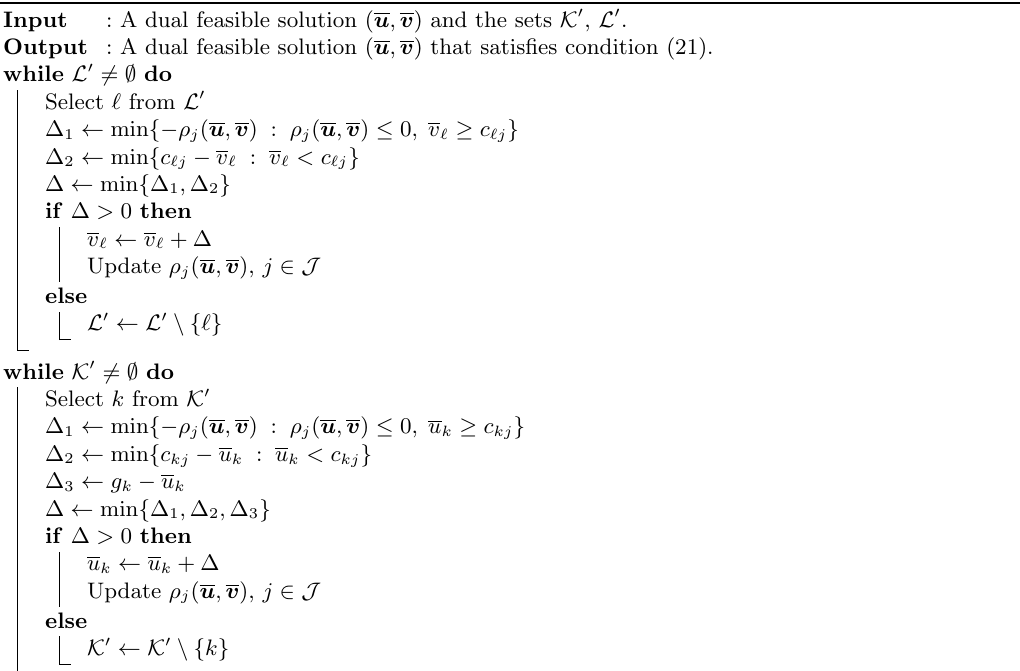
Algorithm 1 : Dual ascent